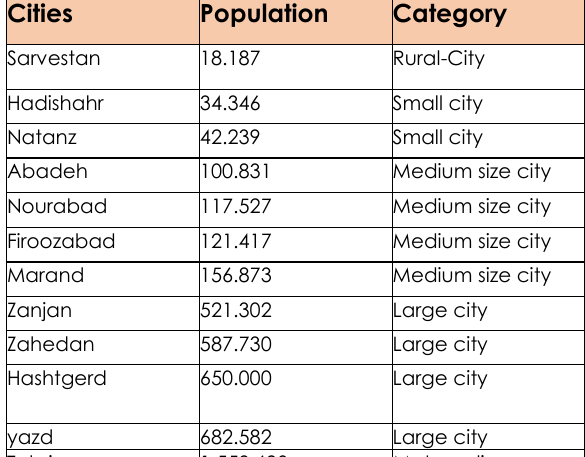
Table 1 : Selected cities (population and size) Cities